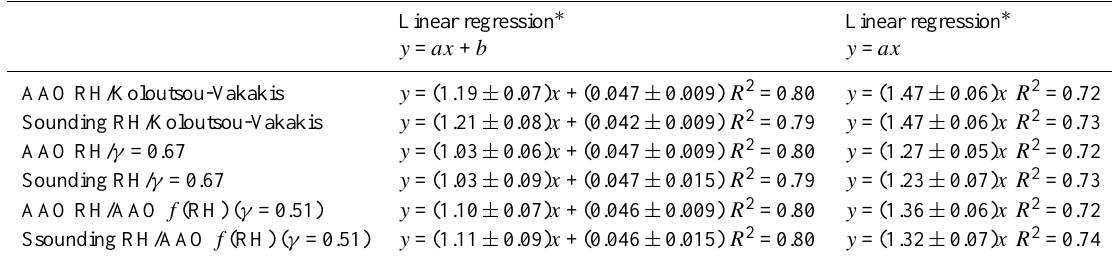
Table 2. Linear regressions and correlation coefficients for the comparison between AERONET and AAO using different measurements of ambient RH and different adjustments to ambient RH. Linear regression ∗ Linear regression ∗